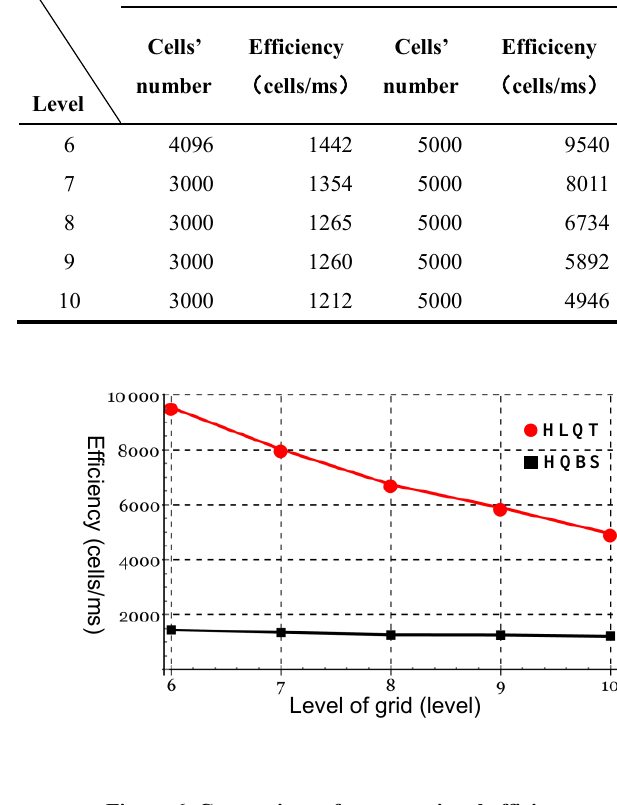
Figure 6. Comparison of computational